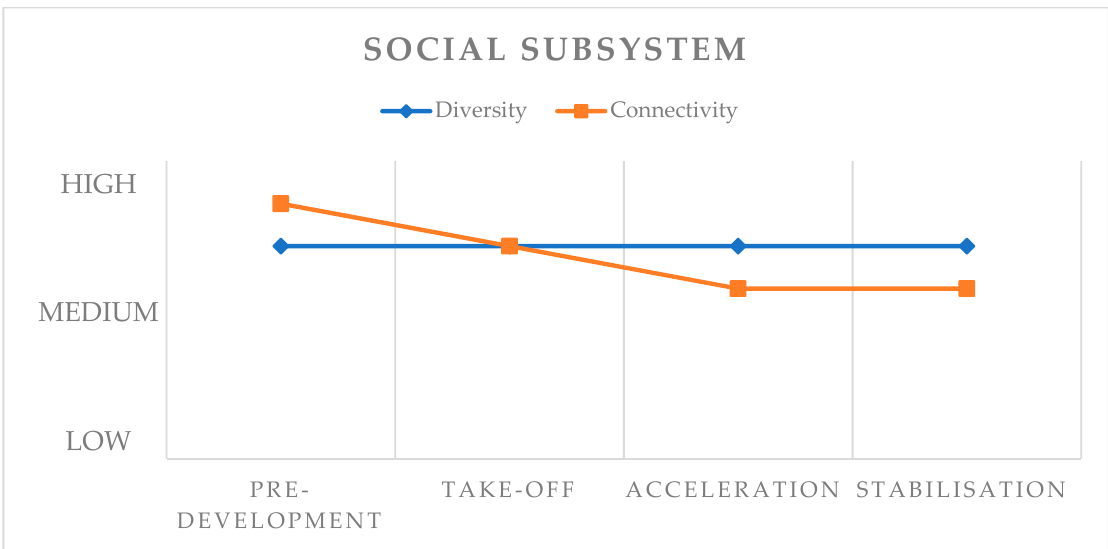
Figure 5. Development of diversity and connectivity measures in the social subsystem.